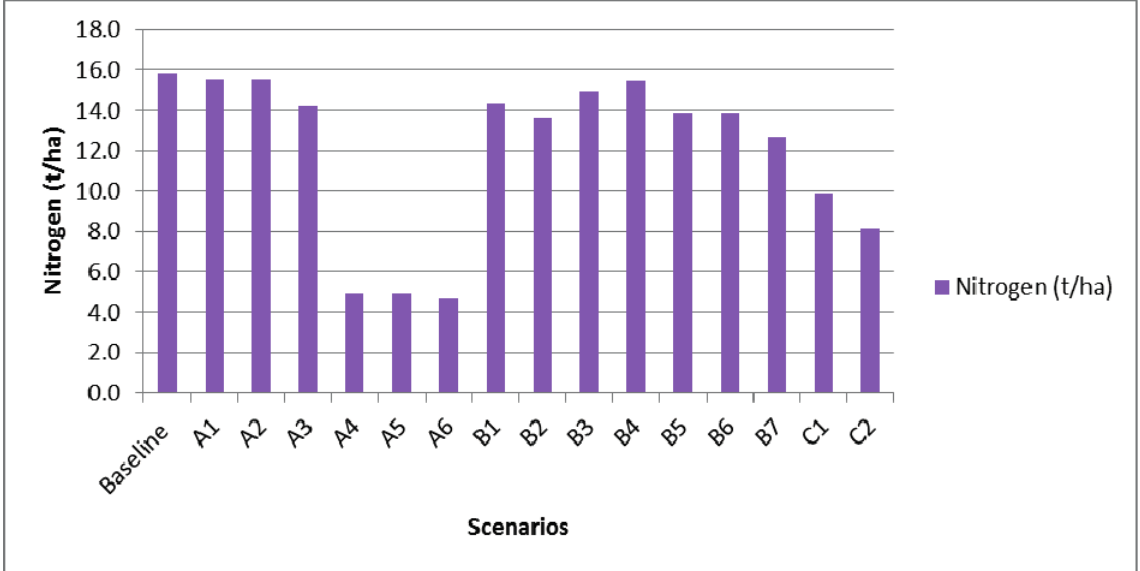
Figure 8. Annual average total nitrogen load at the watershed scale under the 15 different